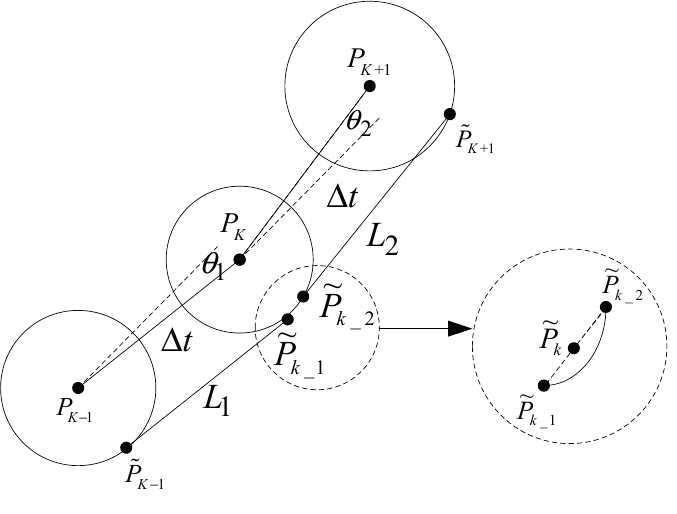
Figure 7. Schematic diagram of double-group constrained